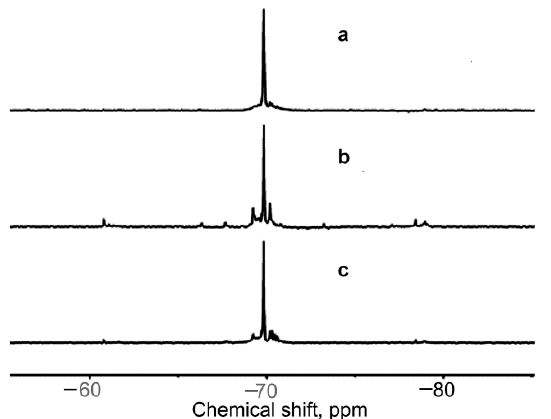
Figure 3. 29 Si NMR spectra of phenylcyclosiloxane compounds from the reaction of 1 carried out for 24 h at C HCl = 0.15 mol L − 1 ( a ); 120 h at C HCl = 0.15 mol L − 1 ( b ), and 24 h at C HCl = 0.26 mol L − 1 ( c ). A number of signals at − 69.0~ − 71.0 ppm, with one at − 69.79 ppm being greatly pre-